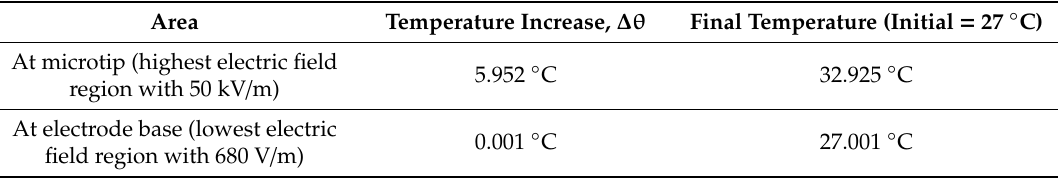
Table 1. Comparison between high and low electric field regions and their produced temperature.